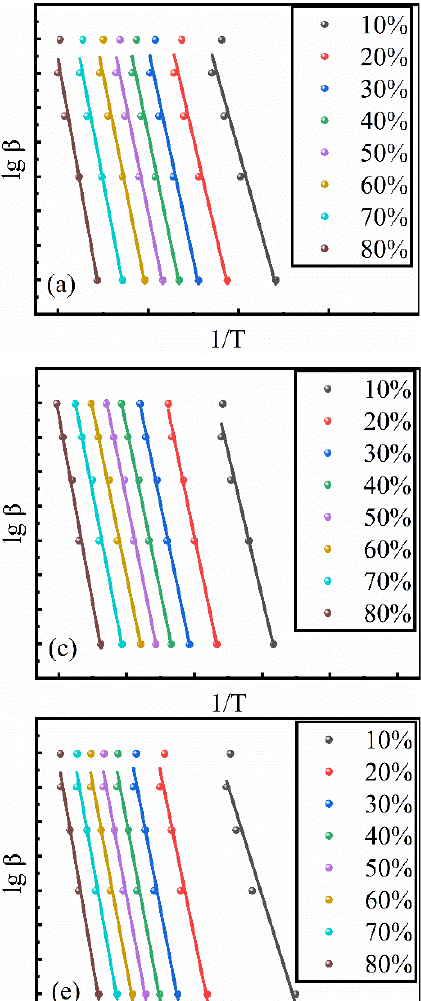
10%), ( c ) EP-(P-M 20%), ( d ) EP-(P-M 25%), ( e ) EP-(P-M